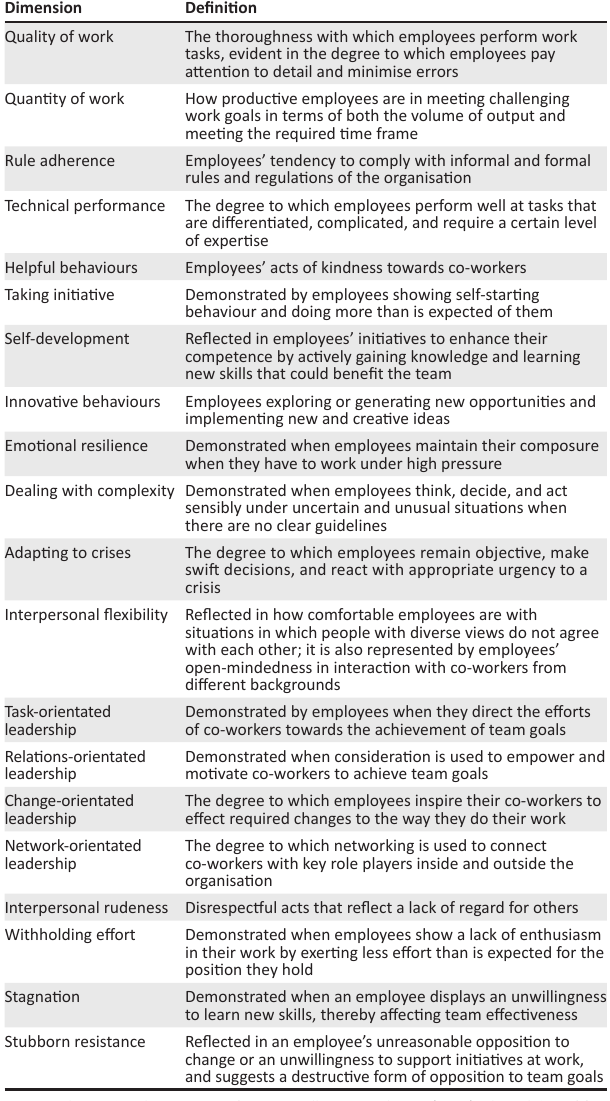
TABLE 1: Definitions of the narrow performance dimensions in the individual work performance review (IWPR).